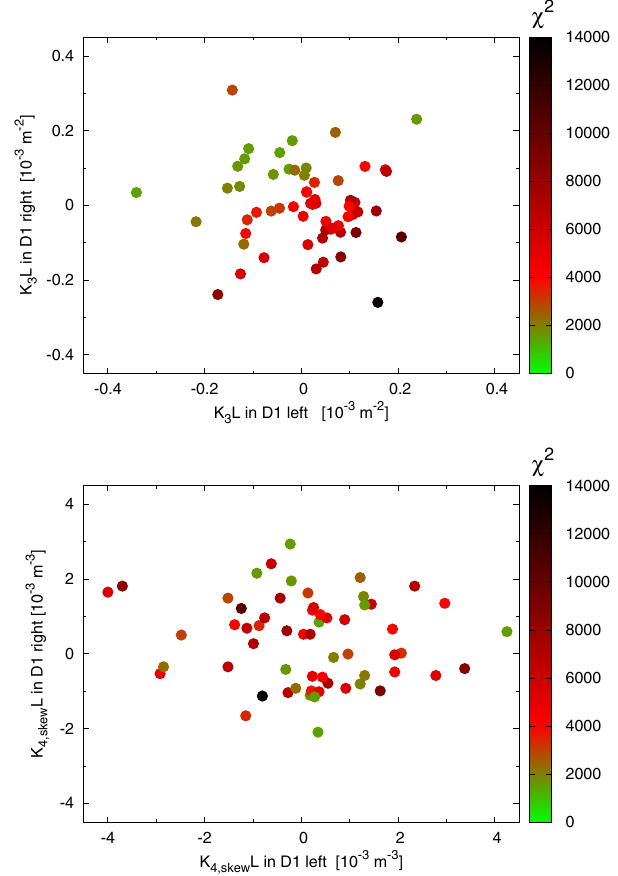
FIG. 8. Integrated normal sextupole and skew octupole com- ponents of the D1 separation dipoles left and right of IP1 at 4 TeV, for the sixty WISE seeds of the LHC. The residual P ðj C − j − j C − j Þ 2 ( ) between the simulated feed-down to cou- Meas Model σ 2 pling and the measured data is indicated in color.